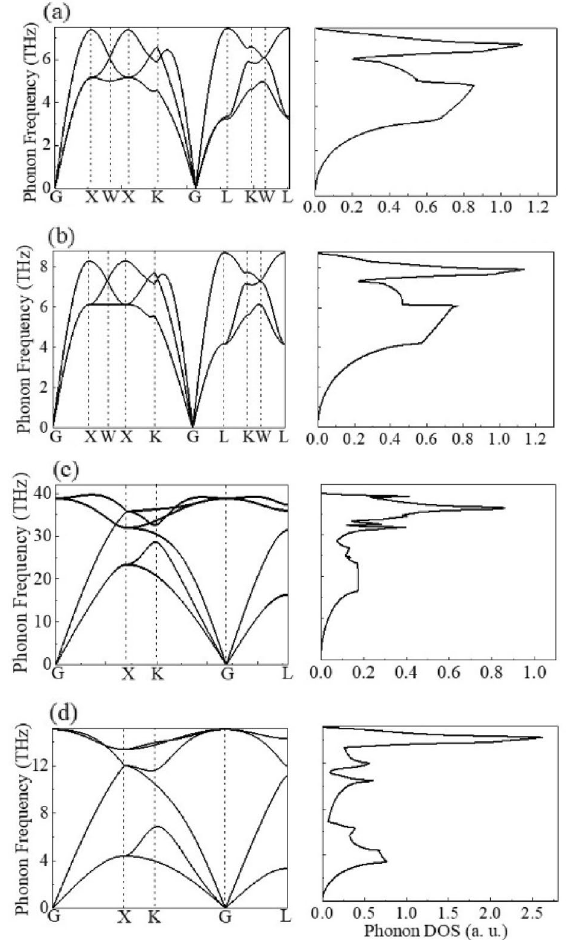
Figure 3. Phonon dispersion curves (left) and phonon DOS (right) for ( a ) Cu, ( b ) Ni, ( c ) diamond and ( d ) Si,